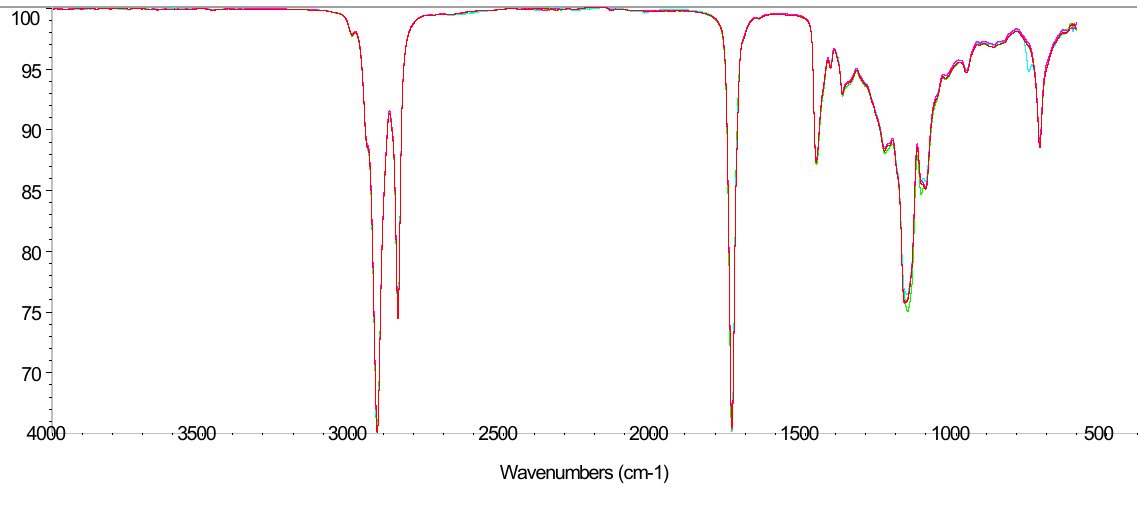
Figure 3: FTIR spectra of beef fat with four extraction